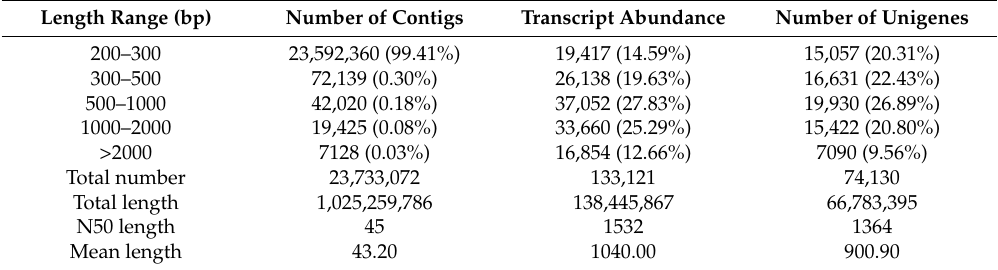
Table 2. Output statistics from assembly of Polygonatum sibiricum transcriptome sequencing.